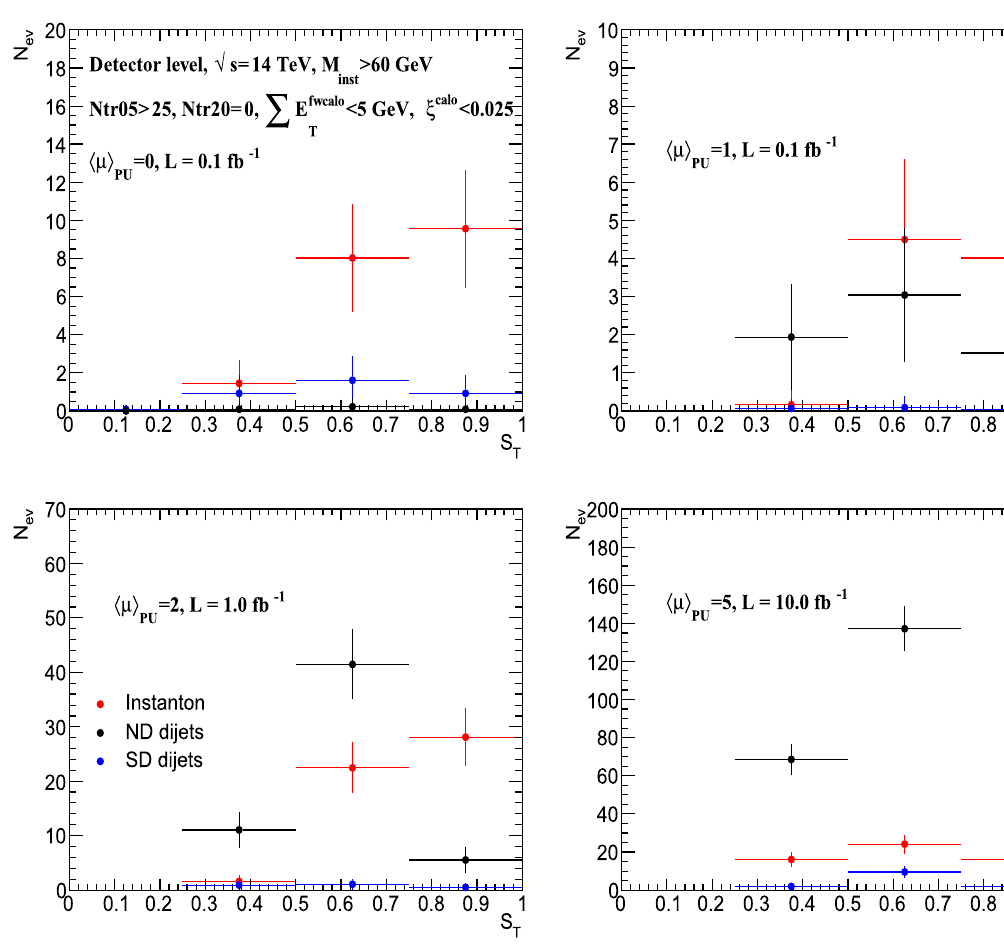
Fig. 3 Distributionsofexpectedeventyieldsasfunctionsoftransverse sphericity at detector level for instanton signal from proton–Pomeron collisions generated by RAMBO for M inst > 60 GeV and backgrounds from ND dijets and SD dijets generated by PYTHIA 8.2 after applying